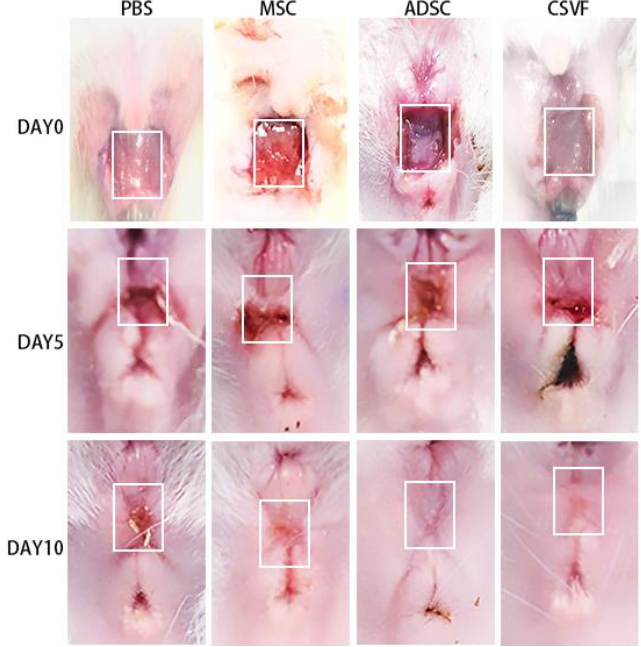
Figure 5. Wound healing in the PBS, MSC, ADSC and CSVF groups on day 0, 5 and 10 after treatment. The first row shows the pictures of the incision in each group of PBS, MSC, ADSC, and CSVF after modeling, the second row shows the healing after 5 days of treatment; the third row shows the healing of the incision after 10 days of treatment. The white box in the figure indicates the injury site.